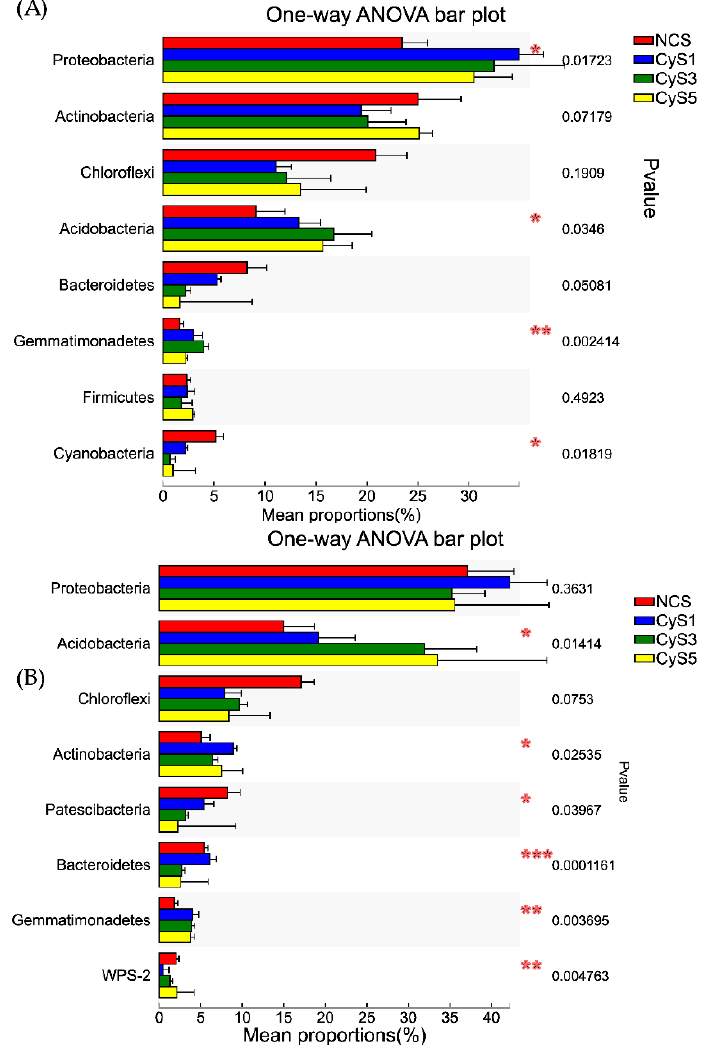
Figure 3. Multiple comparisons between the relative abundance of 8 top bacterial phyla in winter ( A ) and summer ( B ). NCS, fallow field soil; CyS1, one ‐ year C. chinensis cultivated soil; CyS3, three ‐ year C. chinensis cultivated soil; CyS5, five ‐ year C. chinensis cultivated